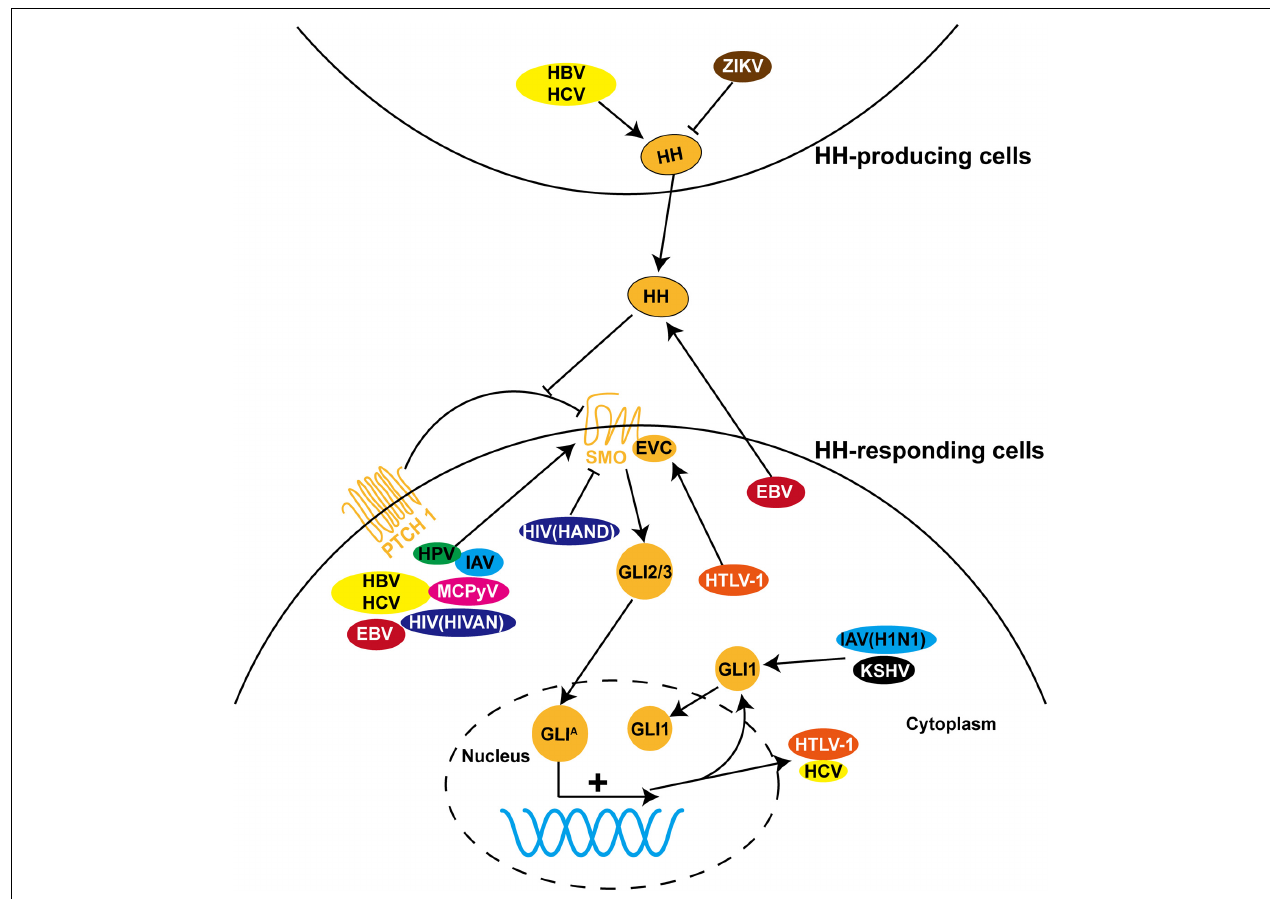
FIGURE 2 | The role of HH signaling in viral infections. HH pathway is dysregulated during infection with a variety of viruses, including hepatitis B virus (HBV), hepatitis C virus (HCV), Epstein-Barr virus (EBV), human papillomavirus (HPV), human immunodeficiency virus (HIV), human T-cell leukemia virus type I (HTLV-1), influenza A virus (IAV), Merkel cell polyomavirus (MCPyV), Zika virus (ZIKV), and Kaposi’s sarcoma-associated herpesvirus (KSHV). Most of these viruses induce pathological processes by regulating the expression, protein stability, and subcellular localization of GLI proteins and other components of HH signaling in HH-responding cells. In contrast, dysregulation of HH signaling is triggered in HH-producing cells by ZIKV and in both cells by HBV and HCV. In addition, HTLV-1 and HCV employ HH signaling to facilitate viral transcription and